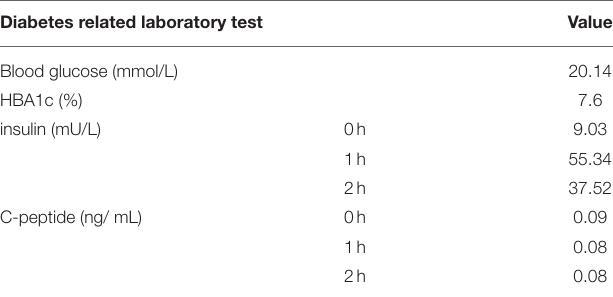
TABLE 2 | The reexamined laboratory test. Diabetes related laboratory